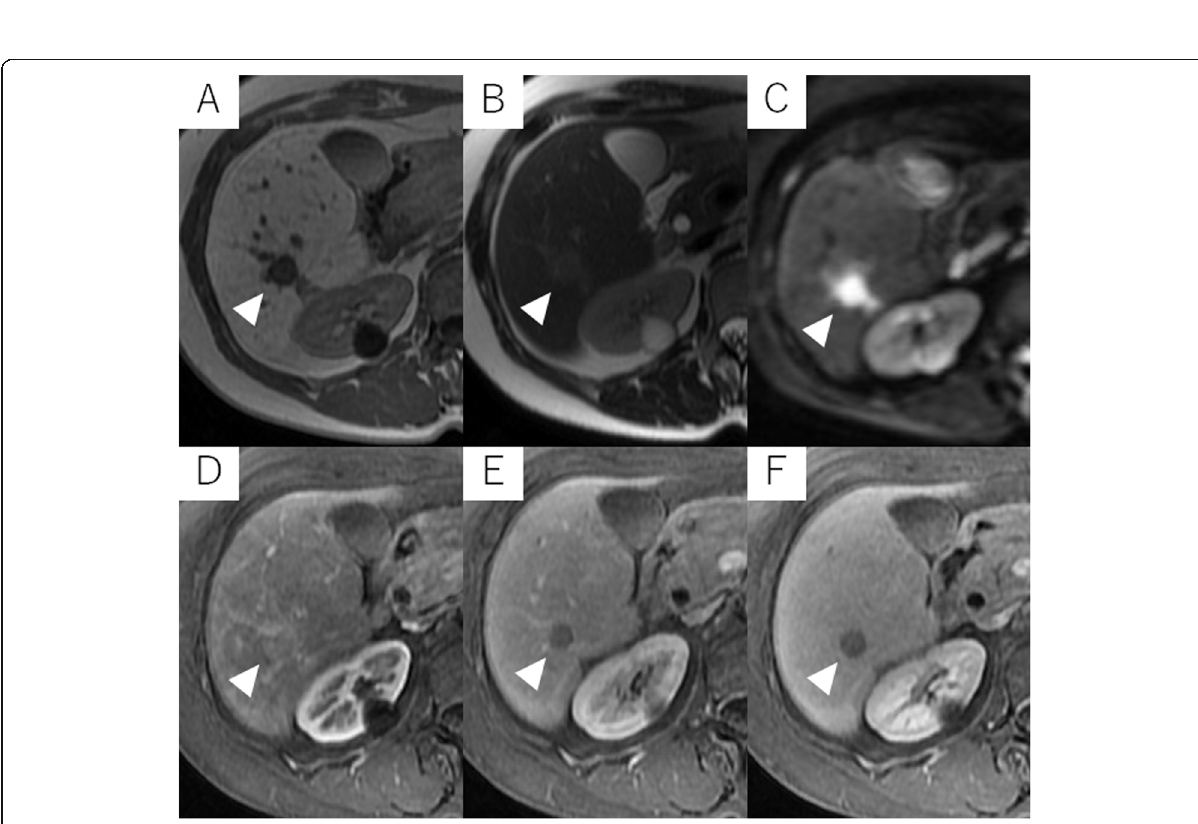
Fig. 3 MRI demonstrates that the nodule shows well-defined low signal intensity in T1-weighted image ( a ), slightly high signal intensity in T2- weighted image ( b ), and strongly high signal intensity in diffusion-weighted image ( c ). Gd-EOB-DTPA-enhanced MRI reveals that the nodule is slightly enhanced in the arterial phase ( d ). The lesion shows perinodular enhancement in the portal phase ( e ) and a defect in hepatobiliary phase ( f ) (white